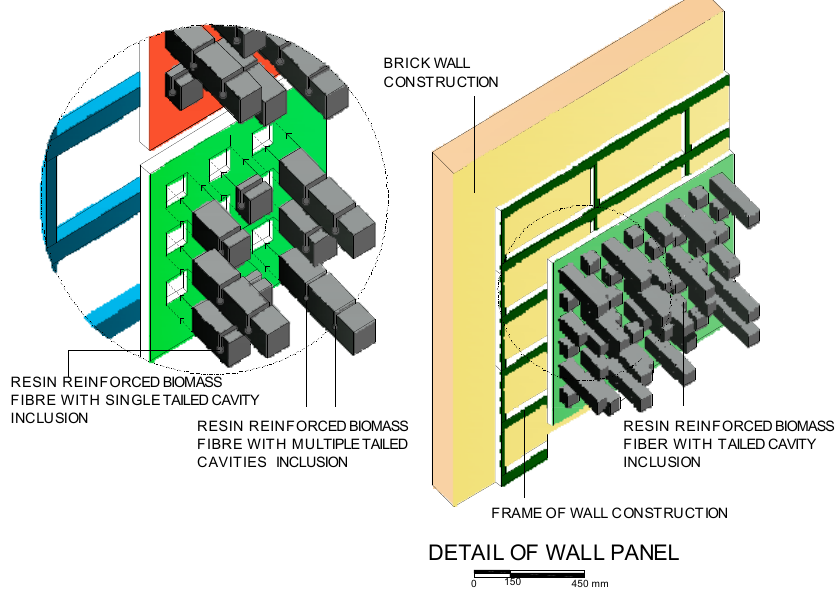
Figure 15. The application of hemp and kenaf on the interior purposes in buildings.as wall panel.